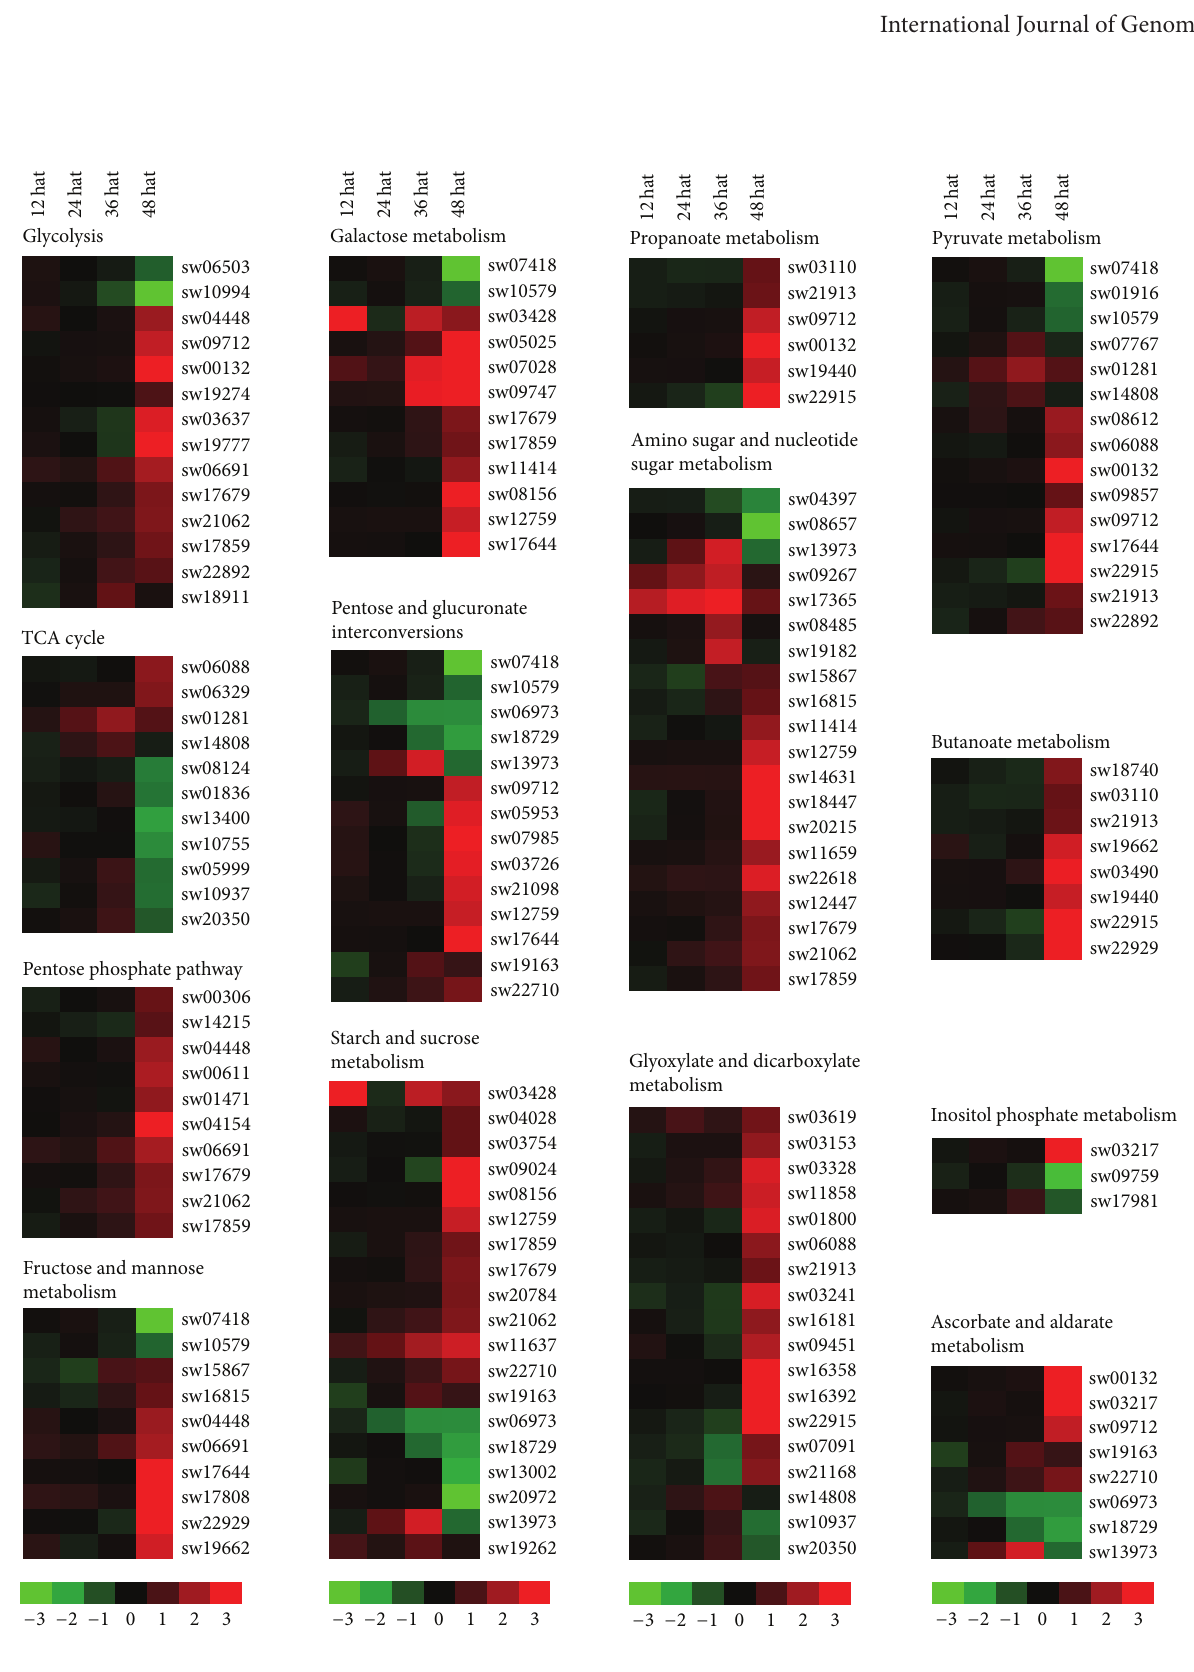
Figure 3: JHA-modulated pathways related to carbohydrate metabolism. Hierarchical clustering of JHA-modulated genes involved in 14 pathways related to carbohydrate metabolism. The probe ID, KEGG ID, and expression intensity of each JHA-modulated gene are listed in Tables S5 and S8. Hat: hours after